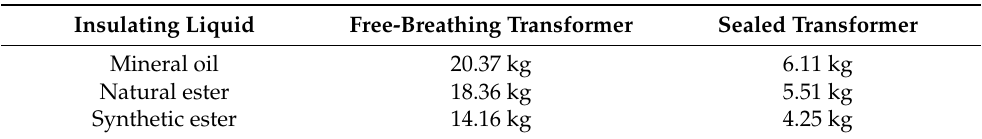
Table 5. Amount of 3A molecular sieve needed to adsorb the annual increase in moisture content of solid insulation in free-breathing and in sealed